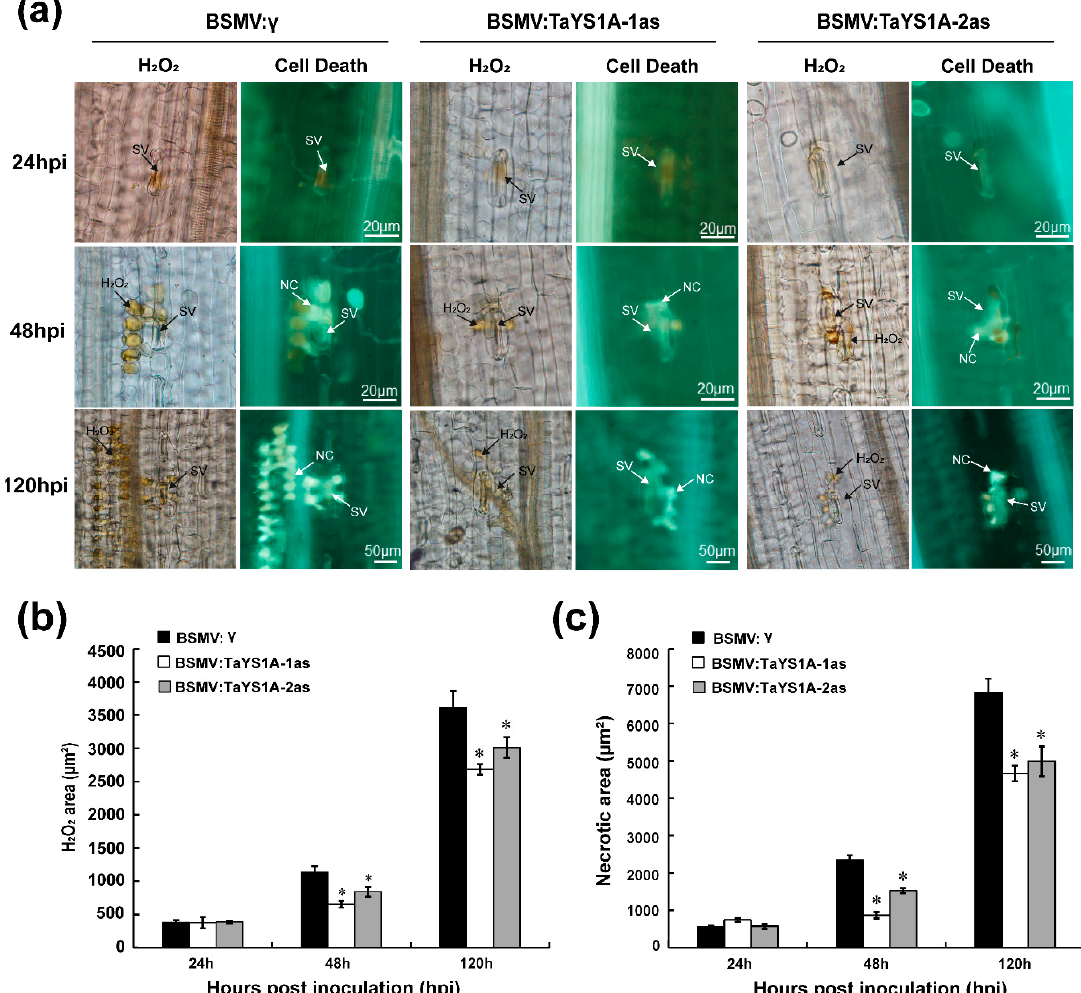
Figure 5. H 2 O 2 accumulation in TaYS1A- silenced leaves was reduced when infected with Pst avirulent race CYR23. ( a ) Histological observation of wheat leaves inoculated with BSMV and infected with CYR23. Wheat leaves pre-infected with BSMV: γ or BSMV:TaYS1A-1/2as were then inoculated with CYR23. 3,3-diaminobenzidine (DAB) was used for H 2 O 2 detection. The necrosis was detected by autofluorescence and was viewed under differential interference contrast optics. SV, sub-stomatal vesicle; NC, necrotic cell. ( b ) The amount of H 2 O 2 production was calculated using DP-BSW tools by measuring the DAB-stained region at each infection site. ( c ) To calculate necrotic cell death, the fluorescence area was measured. Values denote the mean ± standard errors of three independent biological samples. Asterisks designate significant differences ( p < 0.05) from BSMV: γ at same time points by the Student’s t -test.